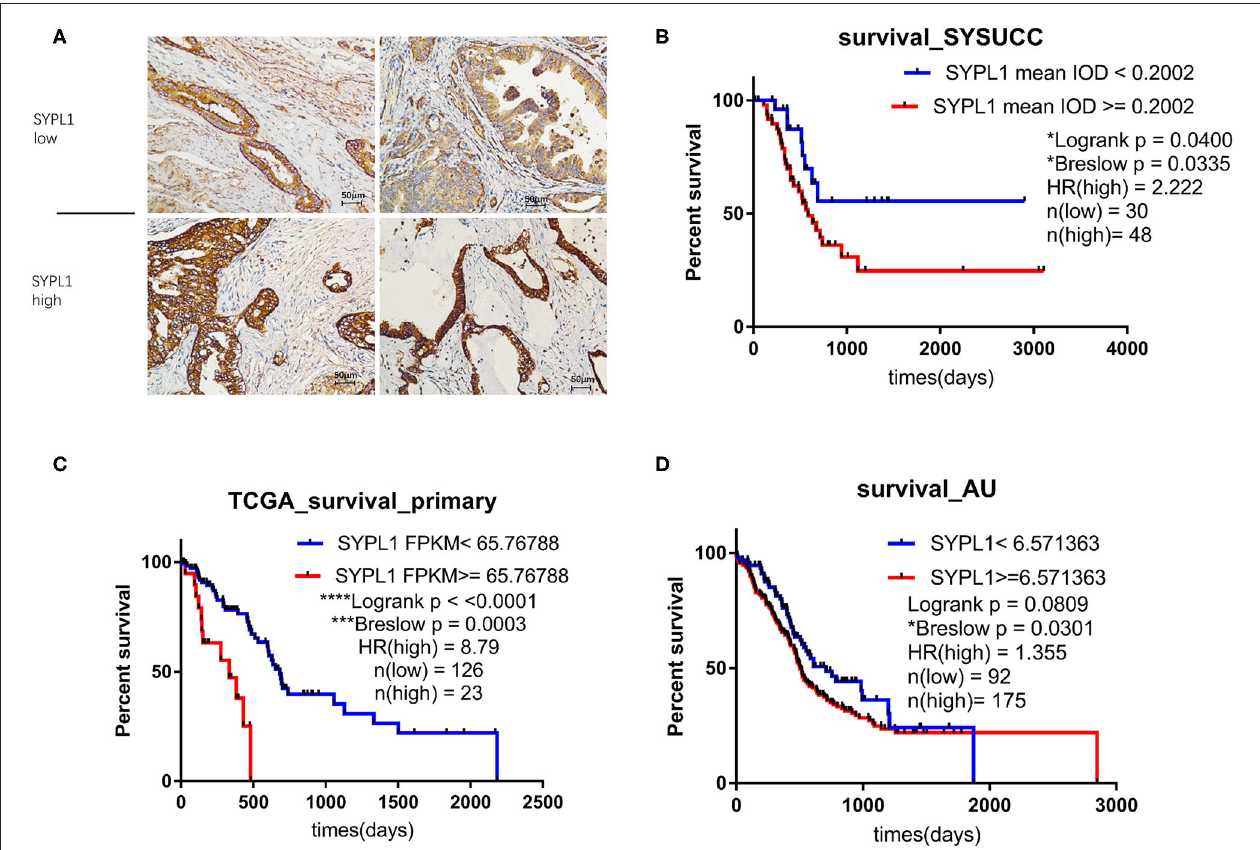
FIGURE 2 | Upregulation of SYPL1 indicated poor prognosis. (A) Two examples of SYPL1-high and SYPL1-low tumor sections. (B) Prognostic effects of SYPL1 on patients from Sun Yat-sen University Cancer Center. (C) Prognostic effects of SYPL1 for patients from TCGA. (D) Prognostic effects of SYPL1 for patients from